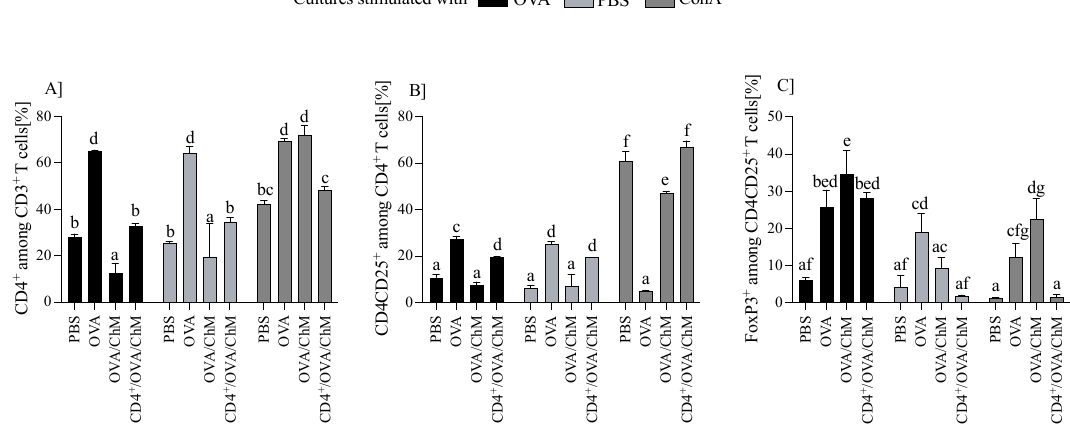
Figure 2. Distribution of T cell subpopulations among lymphocytes from PBS, OVA, OVA/ChM, and CD4 + /OVA/ChM groups after ex vivo culture in the presence of ovalbumin (OVA; black bars), phosphate-buffered saline (PBS; light gray bars), or concanavalin A (ConA; dark gray bars; a positive assay control). The gating tree was as follows: lymphocytes were gated from FSC/SSC; next, CD4 + cells were gated among CD3 + T cells ( A ), and then CD3 + CD4 + CD25 + among the CD4 + cells ( B ); next, the Foxp3 + population was gated among CD3 + CD4 + CD25 + cells ( C ). Each sample was assessed in triplicate and 50,000 events were collected for each assay. Two-way ANOVA with a post hoc Tukey test was used to determine statistical differences. Bars represent the mean of each group ( n = 3) ± SD. a,b,c,d,e,f,g Mean values with different superscripts are different at p ≤ 0.05.